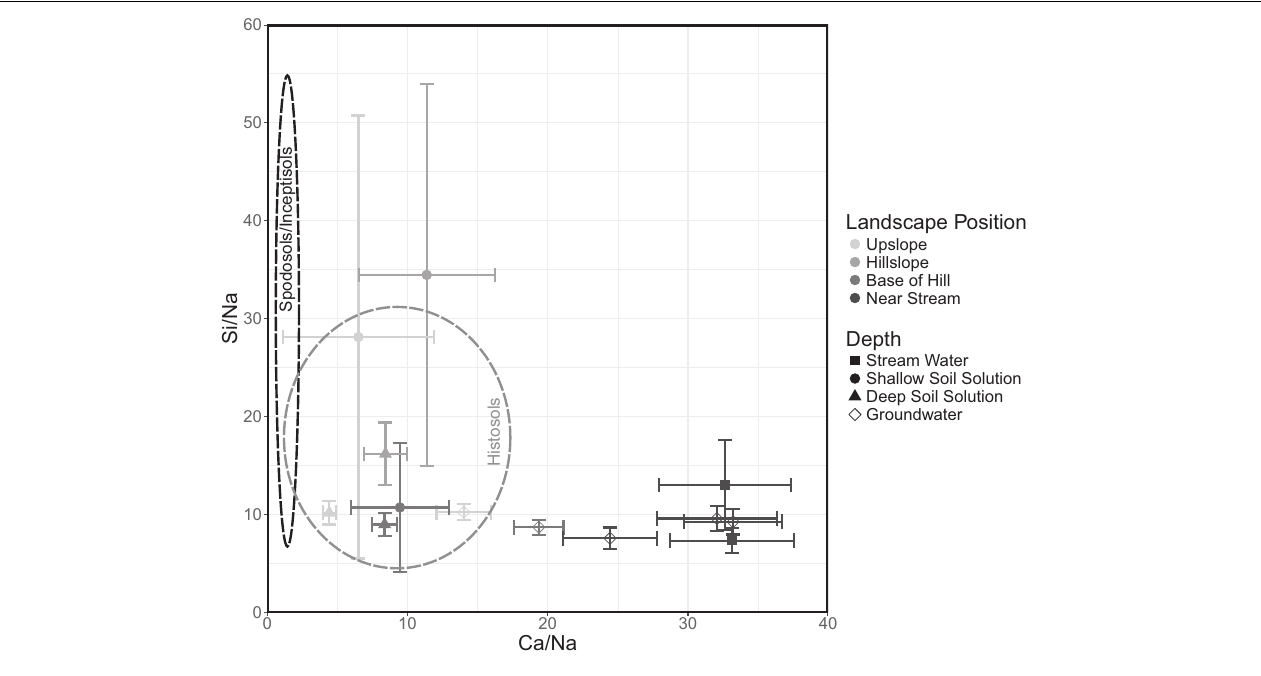
FIGURE 8 | Mixing diagram of Na-normalized mean molar ratios and standard error for water composition by source (symbols) and landscape position (gray shades). Black dashed lines indicate the range of molar ratios in Spodosols and Inceptisols while gray dashed line represents this range in Histosols.